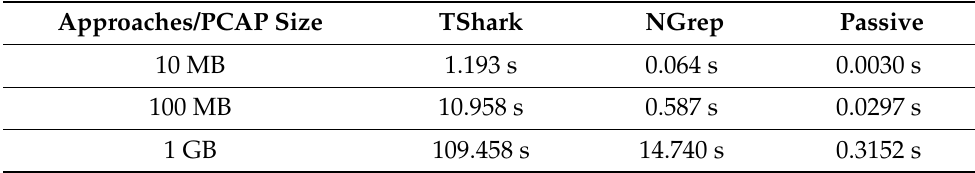
Figure 15. Comparison of the execution time for different tools and 1 GB PCAP file. Table 7. The state-of-the-art comparison between the approach and the execution time for different PCAP